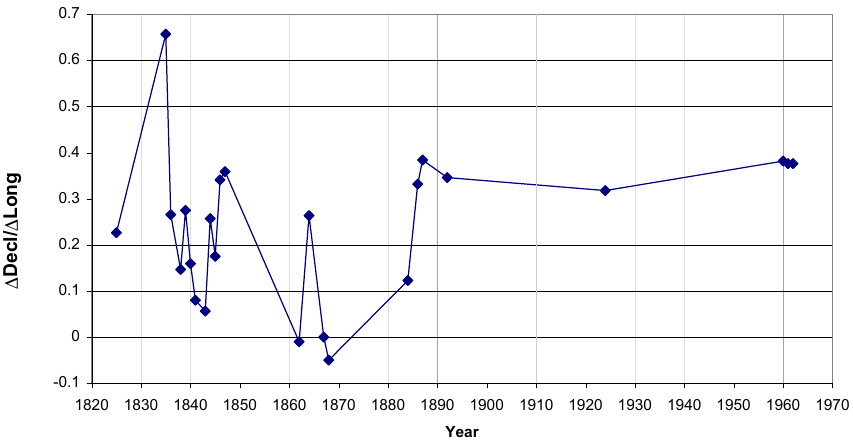
Fig. 5. 1 decl/ 1 long values as derived from data of Fig. 4 versus corresponding years of observation. Significantly greater ( > 1.2) values for years 1831 and 1848 were